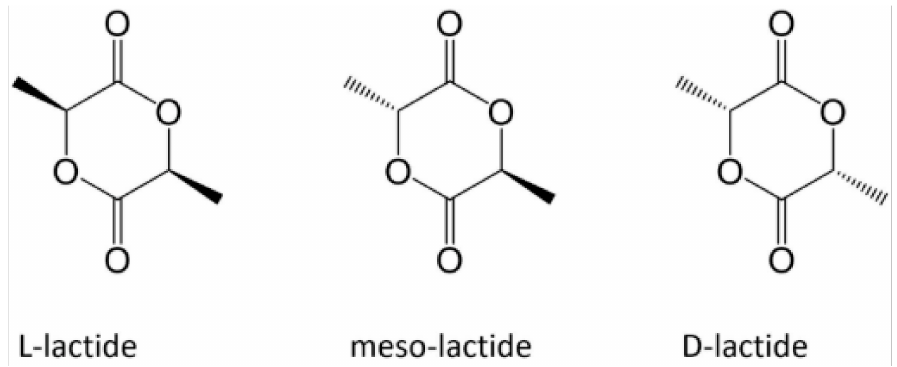
Figure 1. Enantiomeric forms of lactic acid [36]. Reprinted with permission from